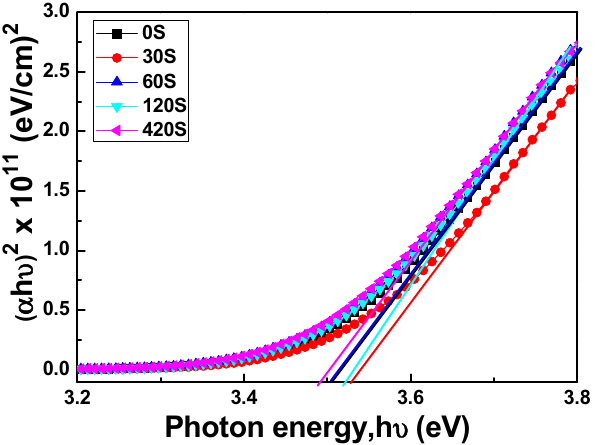
Figure 6. ( α h ν ) 2 versus h ν − E g of FZO films as a function of O 2 plasma pretreatment time.